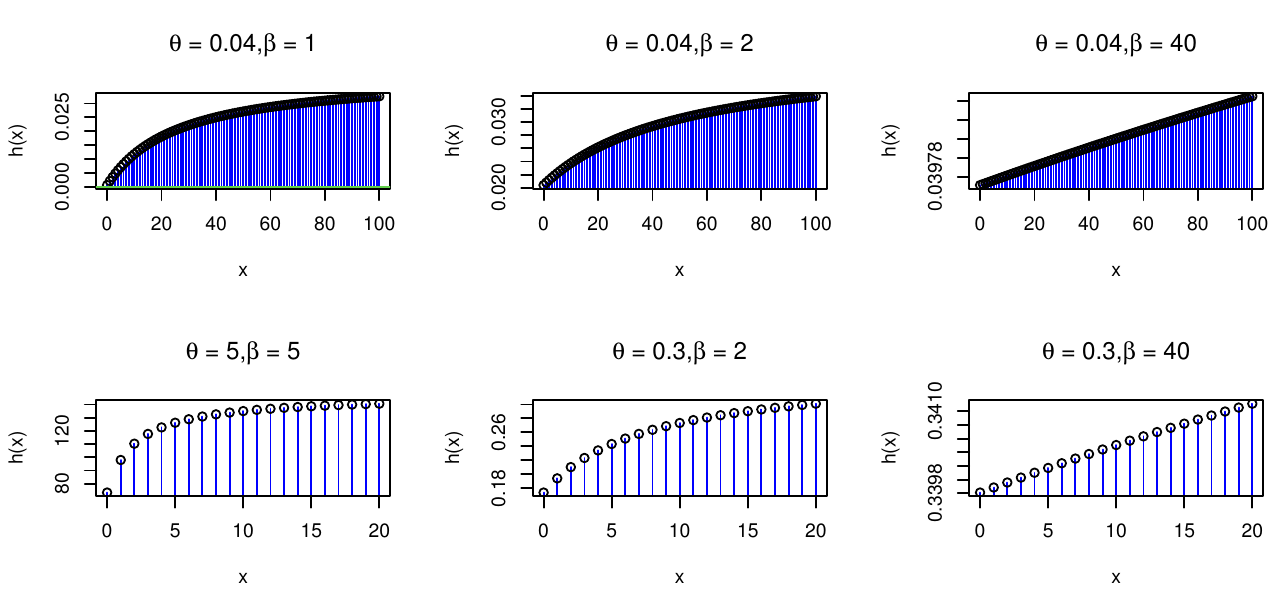
Figure 2. The pmf plots of the DPsL distribution for some set of values for θ and β . Figure 2 clearly indicates that the hrf of the DPsL distribution is always increasing for different values of the